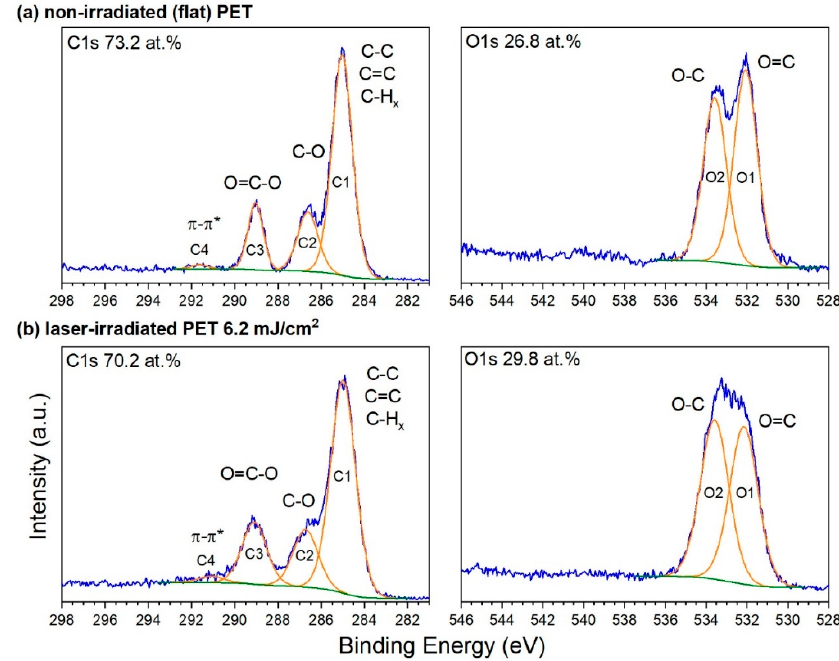
Figure 3. Narrow X-ray photoelectron spectroscopy (XPS) spectra of carbon (C1s) and oxygen (O1s) of non-irradiated ( a ) and ns-laser processed PET samples with low spatial frequency LIPSS (LSFL)-ripples irradiated with a fluence of Φ = 5.7–6.2 mJ/cm 2 at an incidence angle of the laser beam of θ = 30° and with N = 6000 pulses ( b ). The origin of all peaks is provided in Table S2.